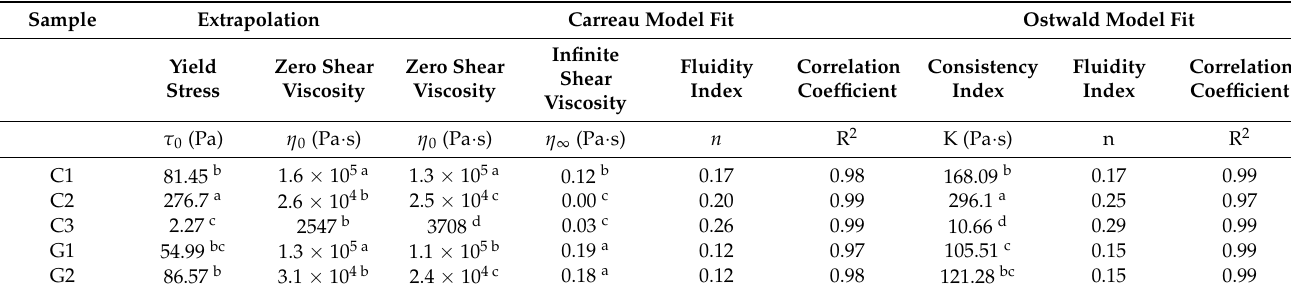
Table 2. Rheological properties of cream and gel samples derived through controlled shear stress flow sweep. Sample